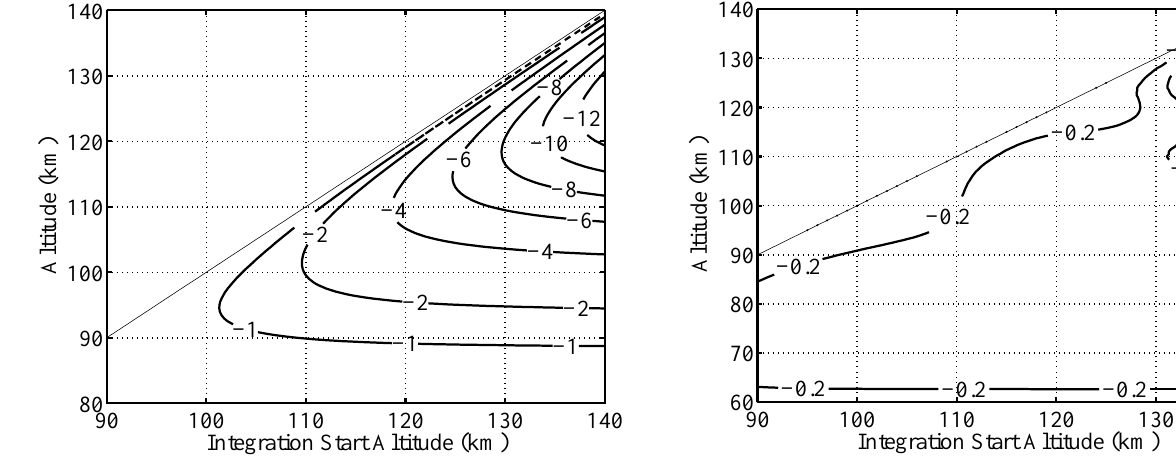
Fig. 5. Similar to Fig. 3 except that the processing correction has been applied.